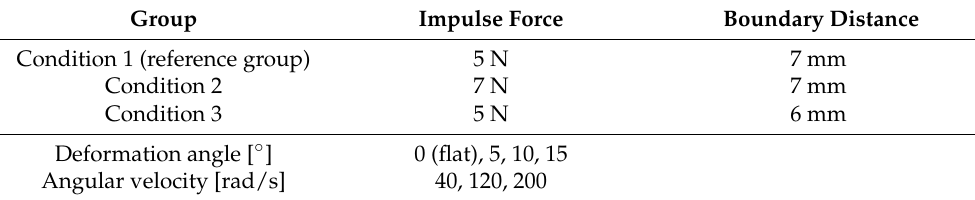
Table 1. Simulation